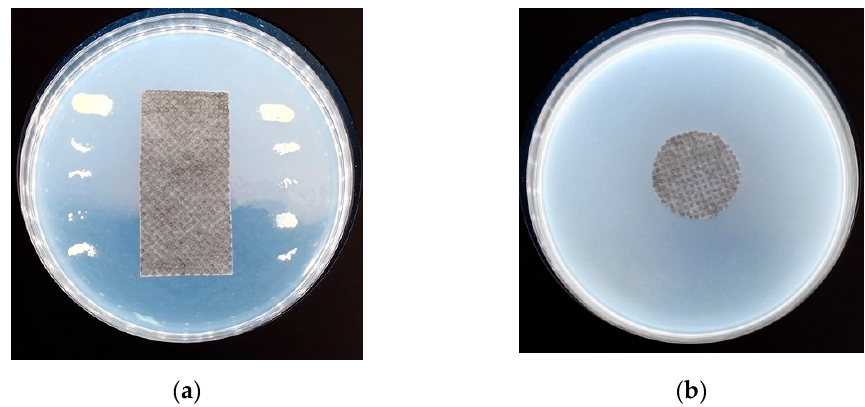
Figure 6. Qualitative methods of assessing antibacterial activity: ( a ) AATCC 147 against S. aureus and ( b ) PN-EN ISO 20645 against E. coli. and ( b ) PN-EN ISO 20645 against E. coli